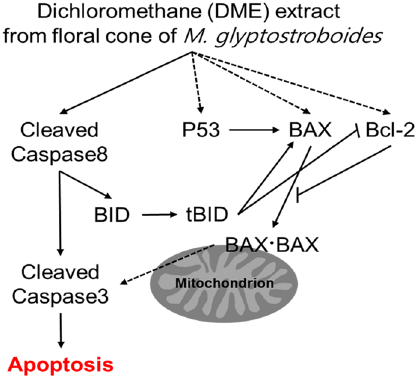
Figure 8. Working model for the mechanism underlying the induction of apoptosis in HeLa cells by the DME extract. The dotted arrows indicate that more evidence is needed to establish a correlation. The solid arrows denote activation. "–" indicates